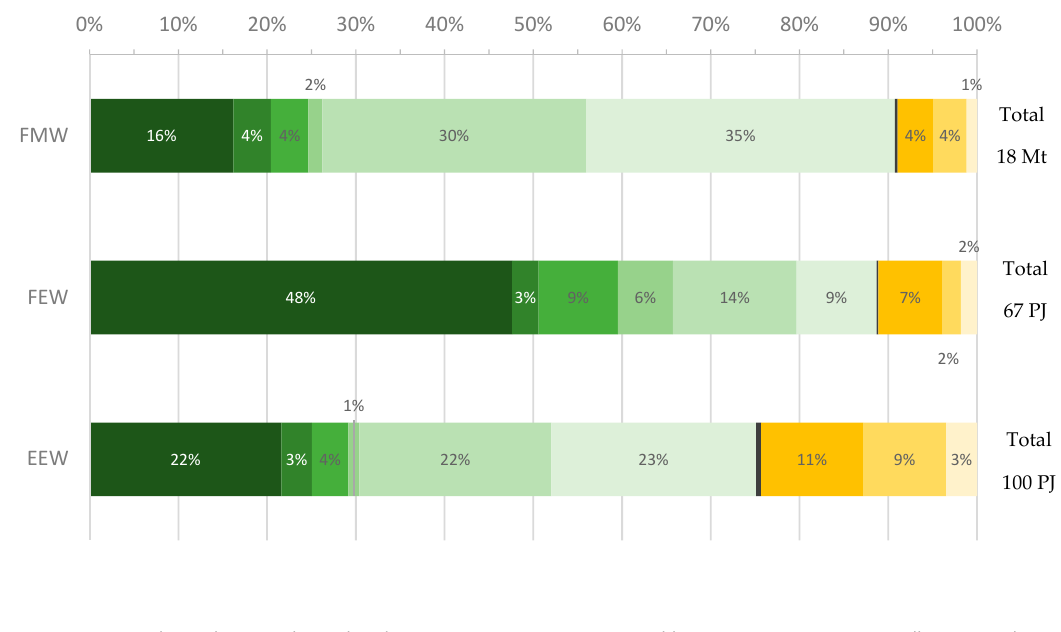
Figure 4. Comparative composition of Food Mass Waste (FMW), Food Energy Waste (FEW) and Embodied Energy Waste (EEW), year 2011.